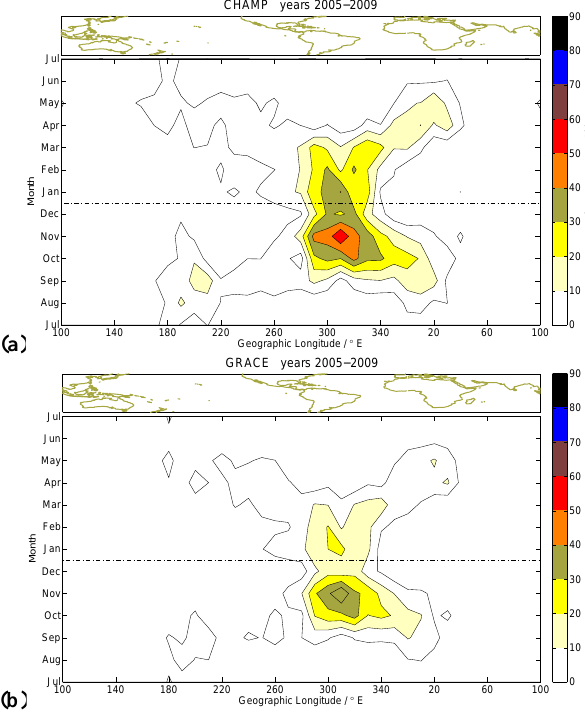
Fig. 6. The same as Fig. 5 but for the low solar activity years (2005– 2009). lyzed the correlation between the EPB occurrence rate and solar flux. Figure 7 shows the globally averaged EPB oc- currence rate versus the solar flux index P10.7, defined as P10.7 i = ( F10 . 7 i + F10 . 7A )/ 2, where F10.7A is the average solar flux index of 81 days centered on the current day. In this case we use solar flux bins of 20 sfu for determining the rates. The percentage of passes falling into each P10.7 bin is plotted as dashed line. As we can see, the EPB occurrence rates exhibit a quite linear relationship with P10.7 over the range P10.7=80–200 both at CHAMP and GRACE altitudes. At CHAMP altitude, the linear equation is y = 0 . 21 x − 11 . 52 and for GRACE, it is y = 0 . 22 x − 18 . 14, where y is the oc- currence rate in percent and x is the solar flux index P10.7. Over the considered solar flux range the linear slope is almost the same for CHAMP and GRACE observations. CHAMP rates, however, are by 5% higher on average. For solar flux levels above P10.7 = 200 occurrence rates seem to rise non- linearly in the case of